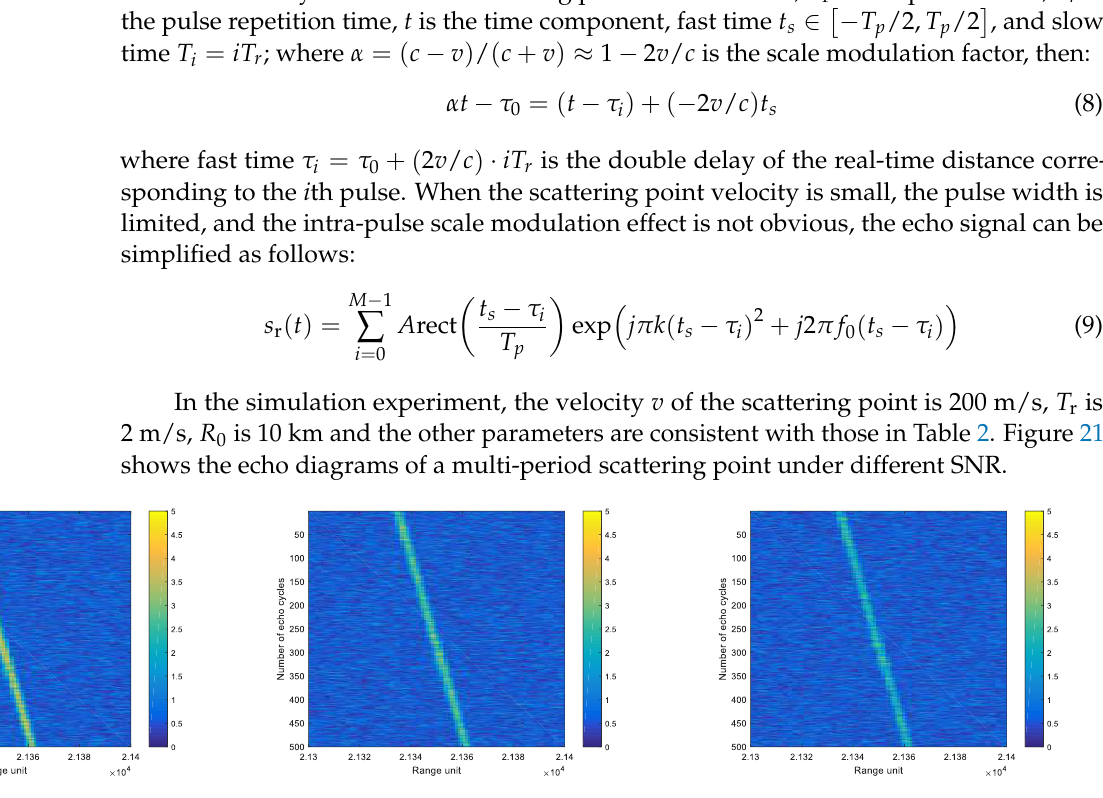
Figure 21. The echo diagrams of multi-period scattering point under different SNR of ( a ) 12 dB, ( b ) 10 dB, ( c ) 8 dB.